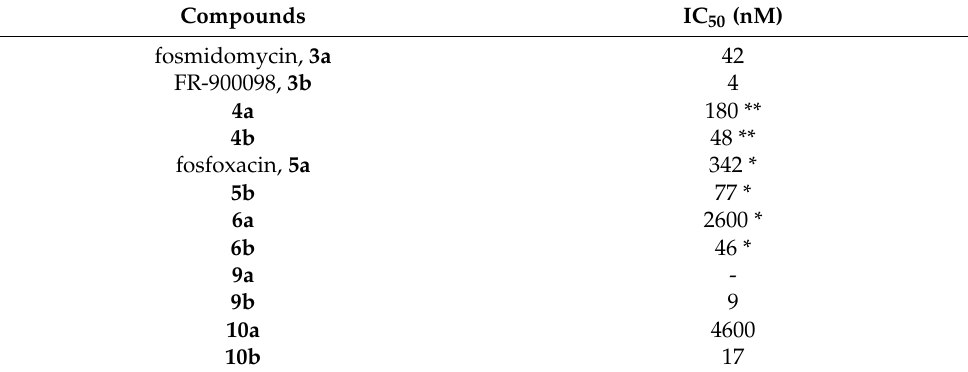
Table 1. Inhibition of E. coli